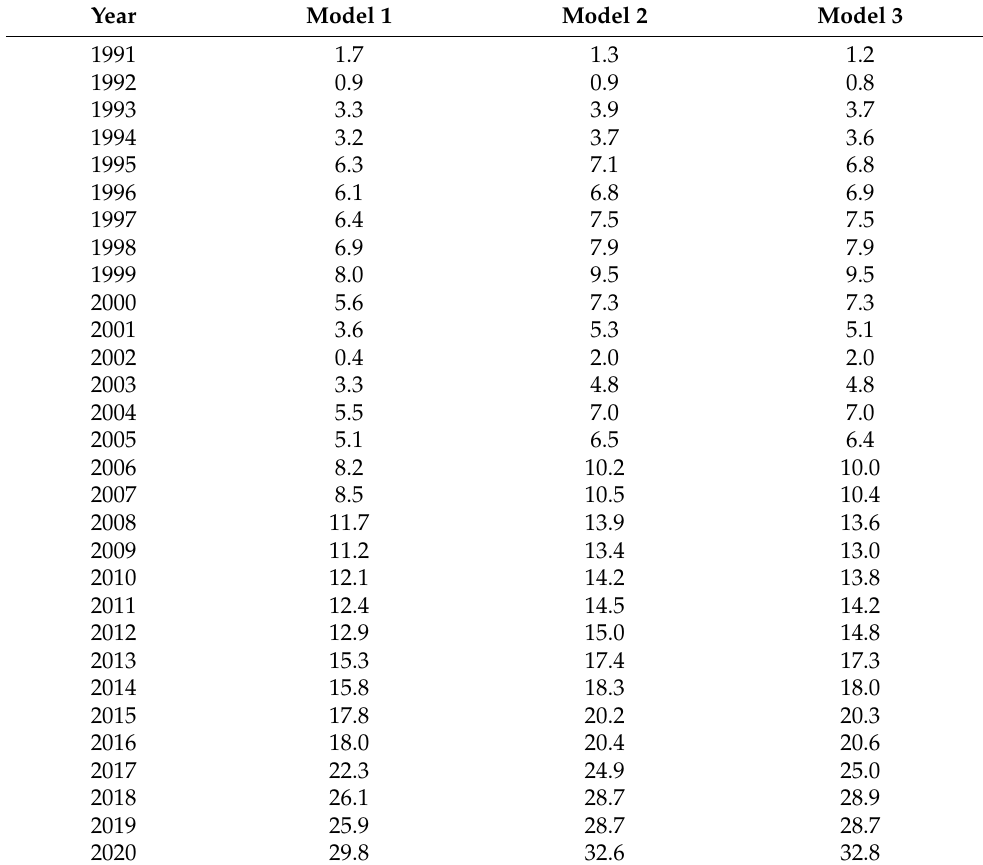
Table 2. Accumulated rates of technological progress estimated for Models 1–3